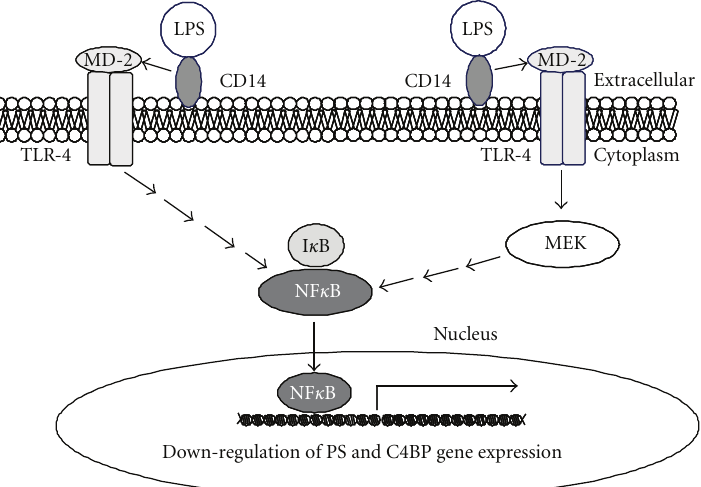
Figure 5: Mechanism of LPS-induced decreased expression of PS and C4BP in hepatocytes . LPS binds to membrane-bound CD14 and TLR-4, followed by activation of MEK/ERK and NF κ B. Activated NF κ B interacts with the promoter regions of the PS and C4BP α and C4BP β genes, leading to decreased PS expression in hepatocytes and SECs, and decreased C4BP expression in